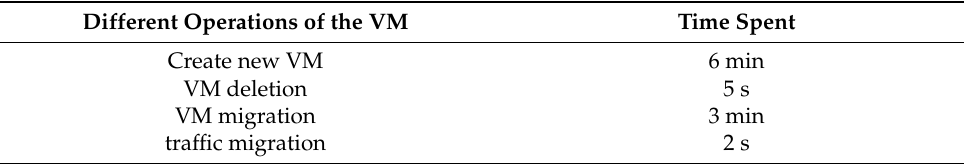
Table 1. The time consumed by different VM operations [4].